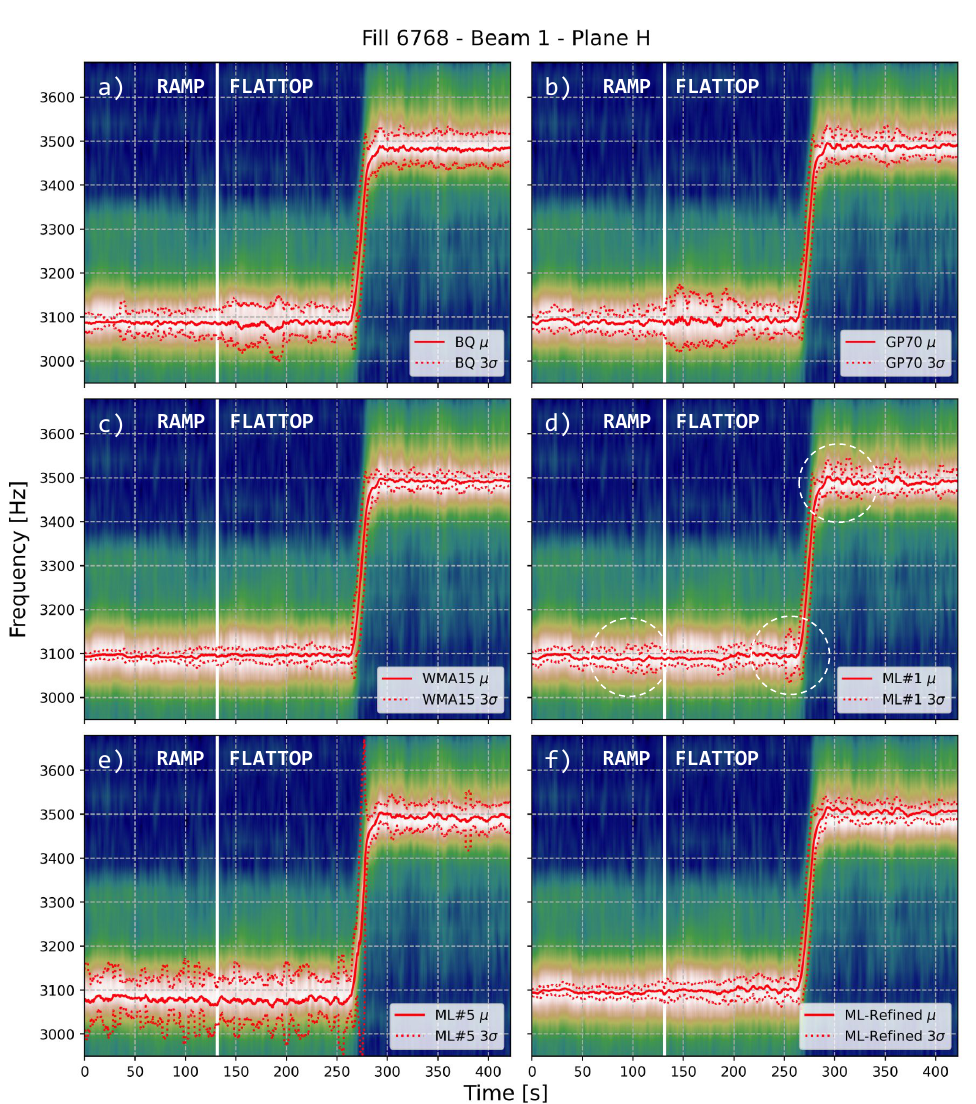
Figure 15. (Background) Heat map obtained by post-processing BBQ spectra from LHC Fill 6768, Beam 1, Horizontal plane, in the transition from RAMP to FLATTOP. (Foreground) Superimposed is the mean, µ , and scaled standard deviation, 3 σ , of the tune evolution as estimated by different tune estimation algorithms and ML models. Three regions of interest are also marked (dashed white circles) ( a ) The original algorithm used in the LHC until Run 2 (BQ) ( b ) Tune estimation using Gaussian Processes with an RBF kernel having a length scale of 70 (GP70) [7] ( c ) Tune estimation using a Weighted Moving Average with a window half length of 15 (WMA15) [7] ( d ) The best DNN model trained using simulated spectra (ML#1) ( e ) The best 1D CNN model trained using simulated spectra (ML#5) ( f ) DNN model with the same architecture as ML#1 and trained using spectra refined by